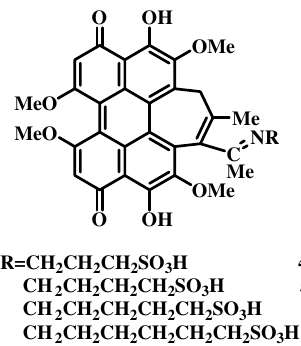
Fig. 4. The molecular structures of 4 – 7 .